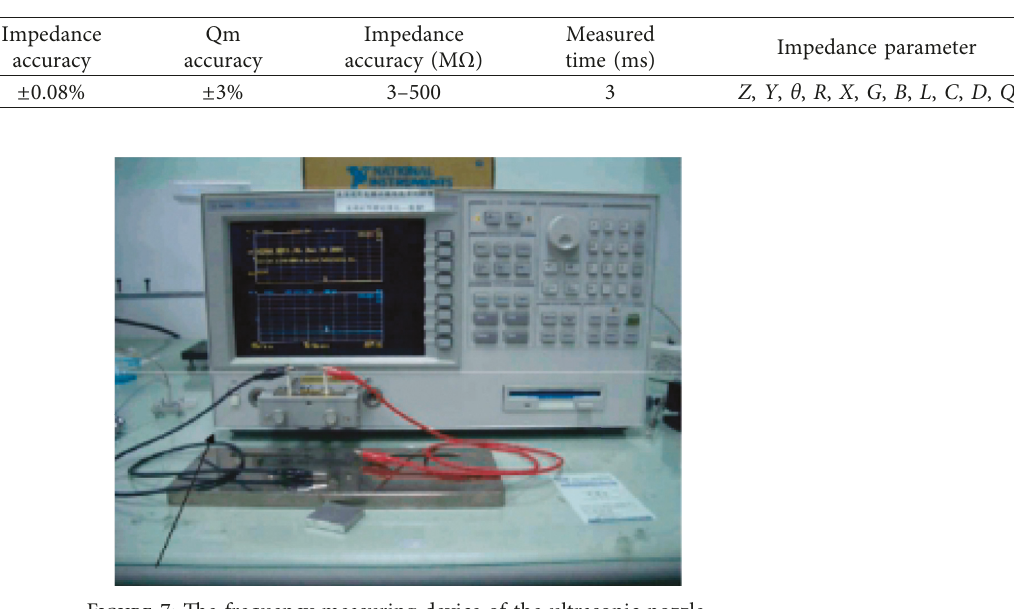
Table 3: The main technical indexes.